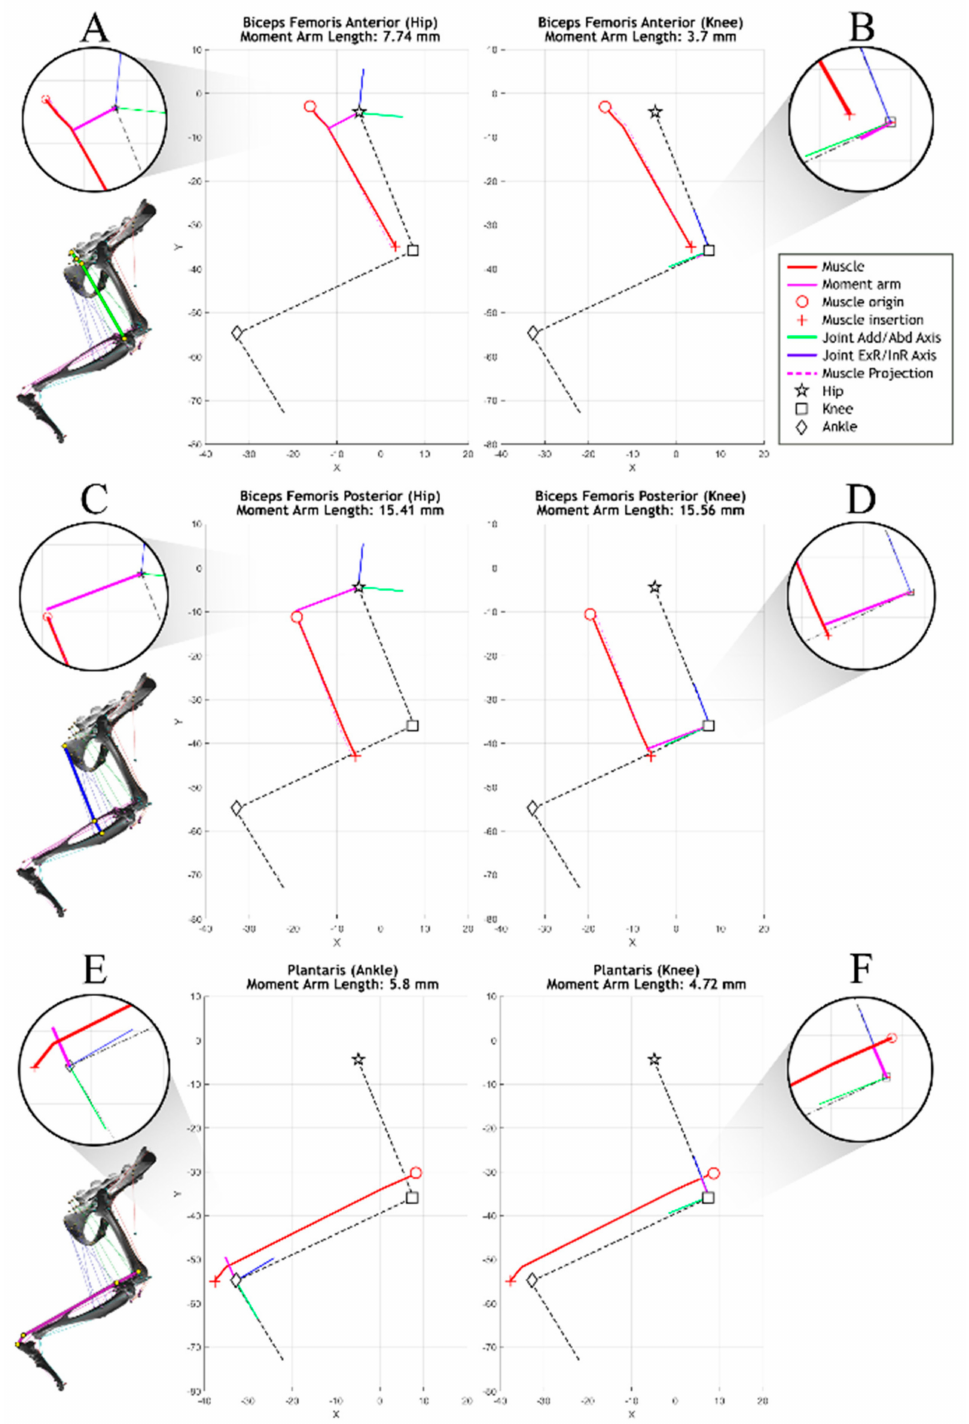
Figure 5. Simulating moment arms for three biarticular muscles including ( A , B ) the biceps femoris anterior, ( C , D ) biceps femoris posterior, and ( E , F ) plantaris. Moment arms (purple) are calculated about each of the spanned joints. Muscle paths are highlighted on the 3D figures on the left with flyouts showing detail about the joint space. Scalar moment arm lengths are derived from these simulations in the sagittal plane. External/internal rotational axes (ExR/InR), represented in blue, and adduction/abduction axes (Add/Abd), represented in green, are shown but not presently